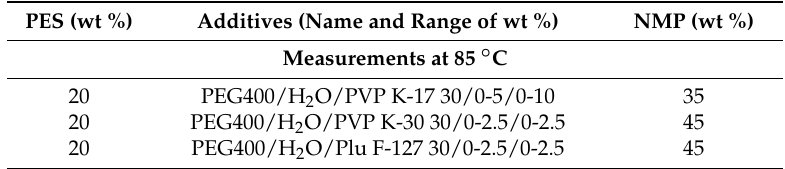
Table 2. Compositions of the polymeric dopes used in the viscosity